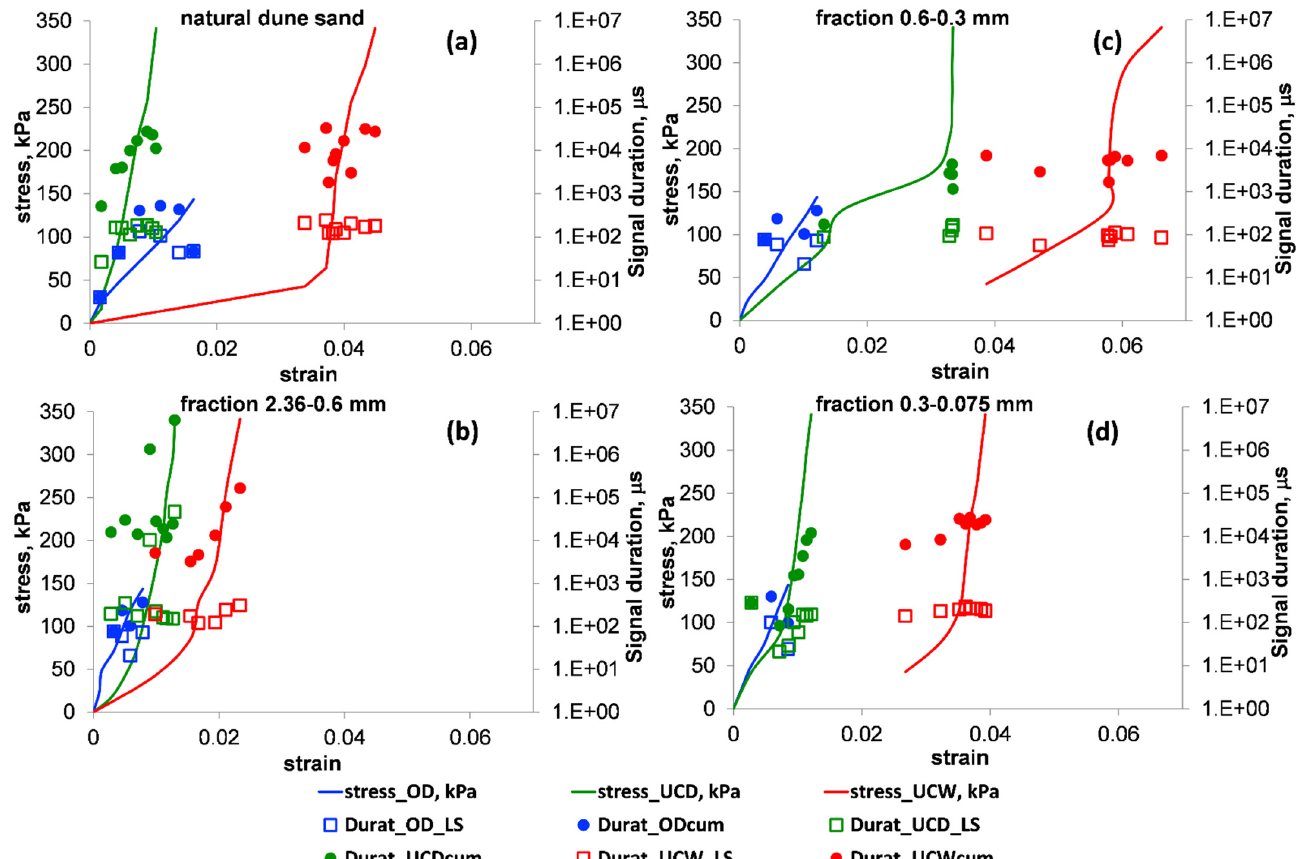
Figure 11. The stress–strain relationships (solid curves) vs. the values of the signal duration (Durat) for the OD (blue), UCD (green) and UCW (red) tests. The empty squares and the full circles denote the values of the average (index = LS) and cumulative (index = cum) signal durations for a loading stage, respectively. Panels ( a – d ) present the results for natural dune sand and its three extracted fractions: 2.36–0.6, 0.6–0.3 and 0.3–0.075 mm, respectively. Note that in the used number format, the notation “E ± xx” is part of a scientific notation and corresponds to “ · 10 ± xx